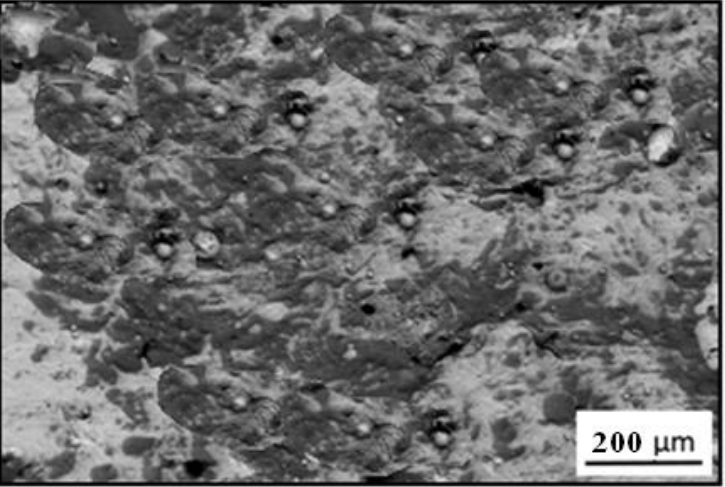
Figure 3. SEM image of the top surface of the Cr 3 C 2 -25(Ni20Cr) cermet coating on the Al7075 sub-